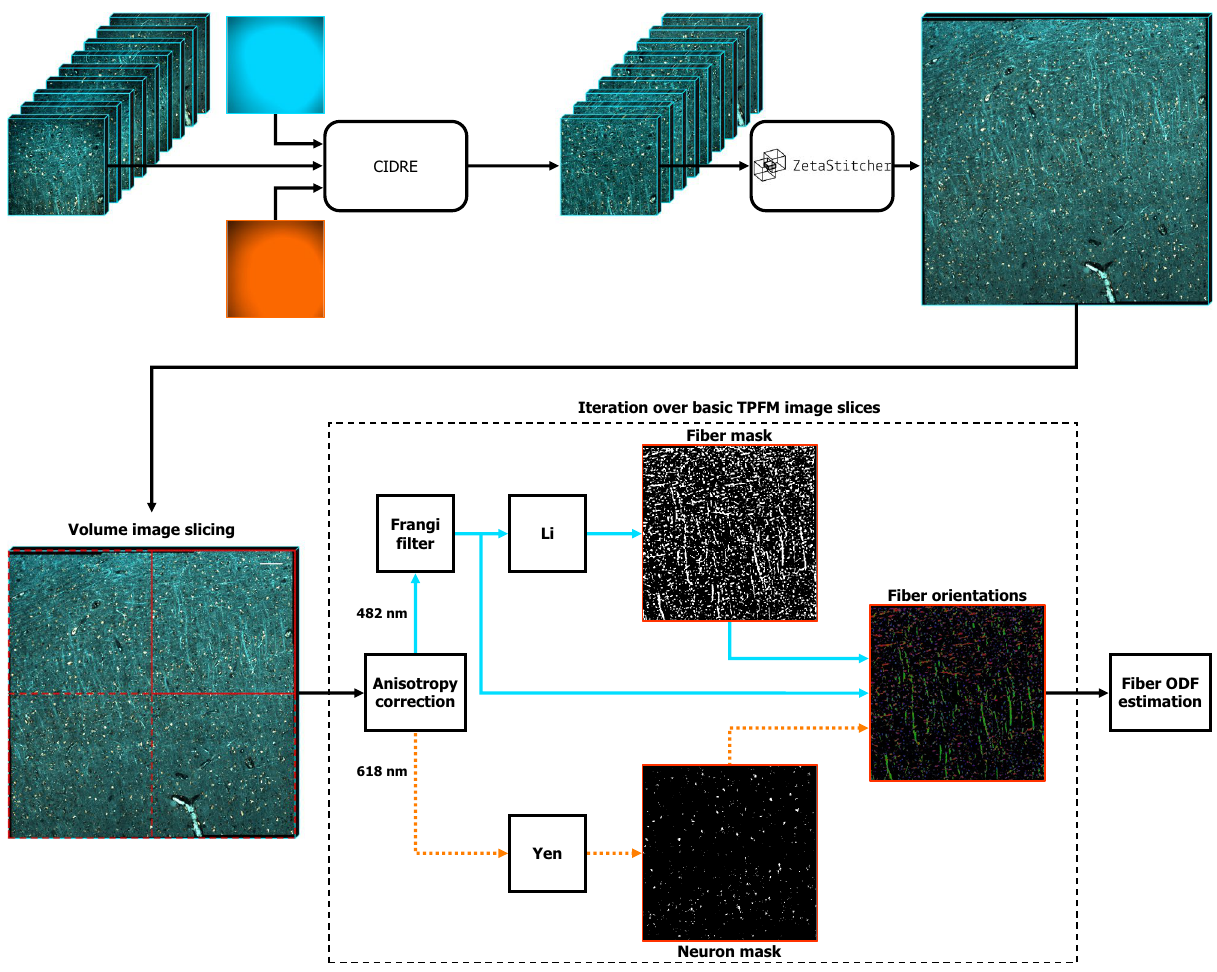
Figure 9. Block diagram schematizing the image processing pipeline for the 3D analysis of myelinated fiber orientations. Adjacent microscopy image stacks are preliminary corrected for shading using the CIDRE